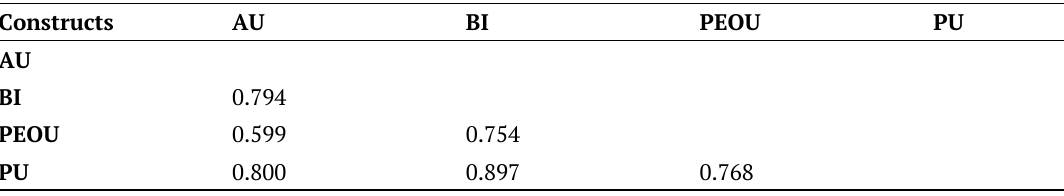
Table 5. Heterotrait-Monotrait Ratio (HTMT)